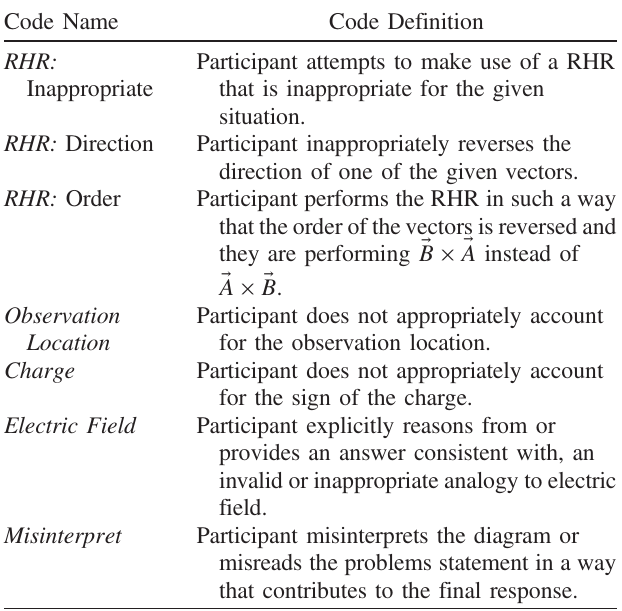
TABLE VI. Brief definitions of the error types discussed in the text. Descriptions of all error types can be found in the Appendix (Table VIII). The definitions here correspond to ‘ Error ’ subcodes, where subcodes of ‘ Corrected ’ or ‘ No Error ’ are also possibilities. For Charge and Electric Field , explicit and implicit errors were categorized